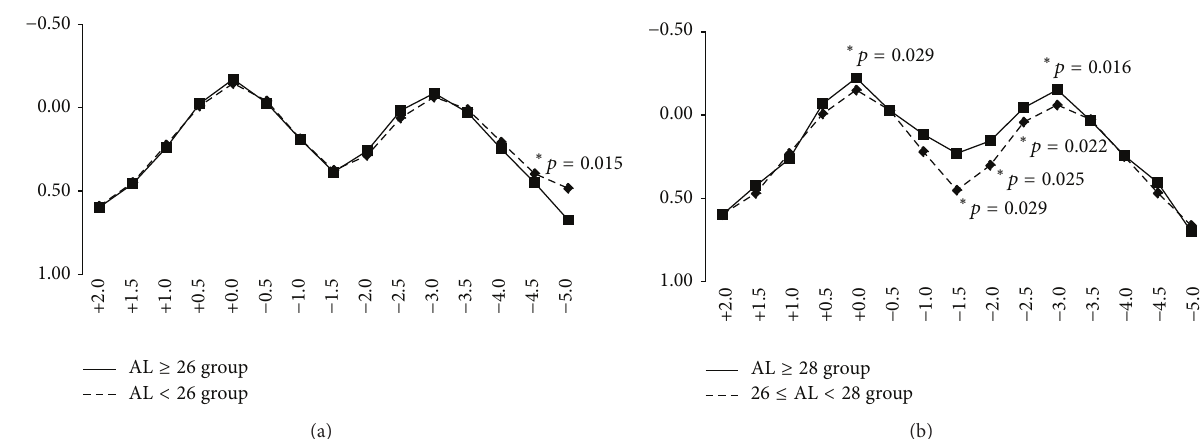
Figure 6: Defocus curves. (a) Eyes were divided into axial length of 26 mm or longer (AL ≥ 26 group) and less than 26 mm (AL < 26 group). Bimodal curves are shown with two peaks at spherical equivalent addition of 0.0 D and −3.0 D. Although a significant difference between two groups is observed at spherical equivalent addition of −5.0 D, no significant differences were found at the other values. (b) Eyes in AL ≥ 26 group were further divided into 26 ≤ AL < 28 group and AL ≥ 28 group. Bimodal curves are also observed. Significant differences are detected at additional spherical equivalent of 0.0, − 1.5, − 2.0, − 2.5, and − 3.0D. ∗ Mann-Whitney 𝑈 test.